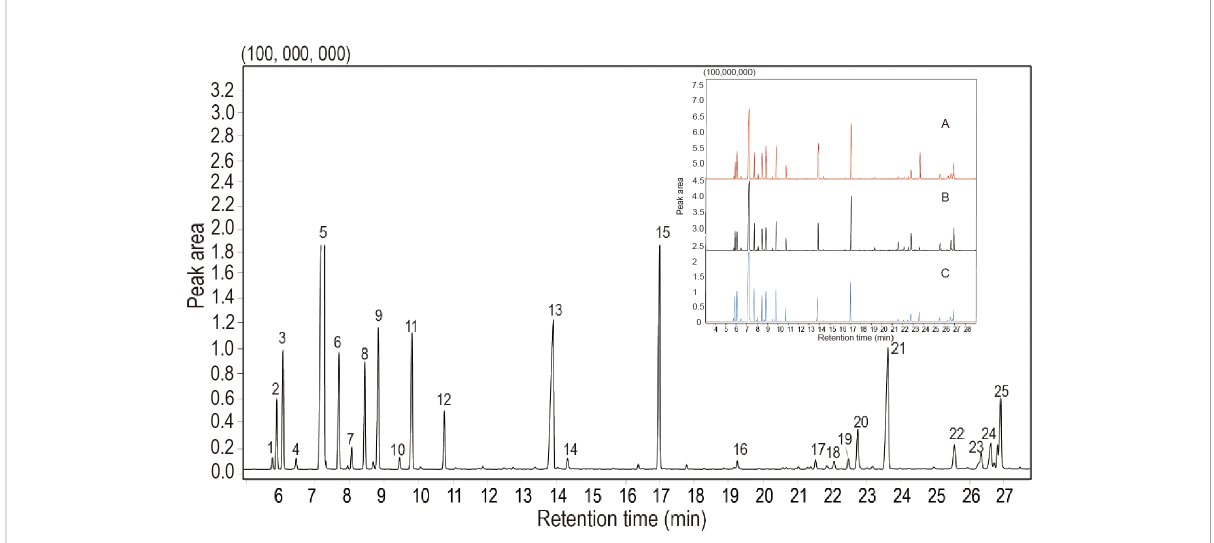
FIGURE 3 Total ion current chromatogram of essential oils from Sabina chinensis leaves analyzed using a gas chromatograph-mass spectrometer.